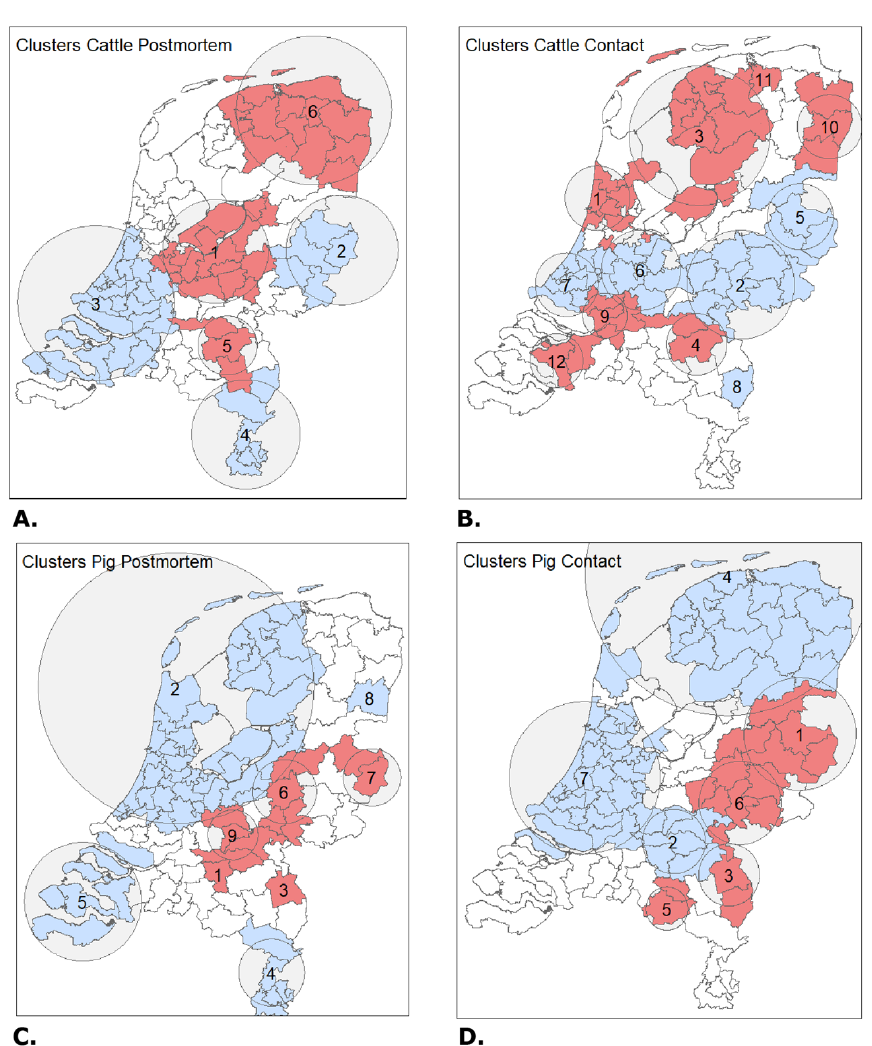
Figure 4. High (red) and low (blue) clusters for helpdesk contact and postmortem examination. ( A ) postmortem examination of cattle, ( B ) Helpdesk contacts cattle, ( C ) postmortem examination of pig, ( D ) helpdesk contacts pig. Numbers within clusters represent order of significance, all shown clusters p <